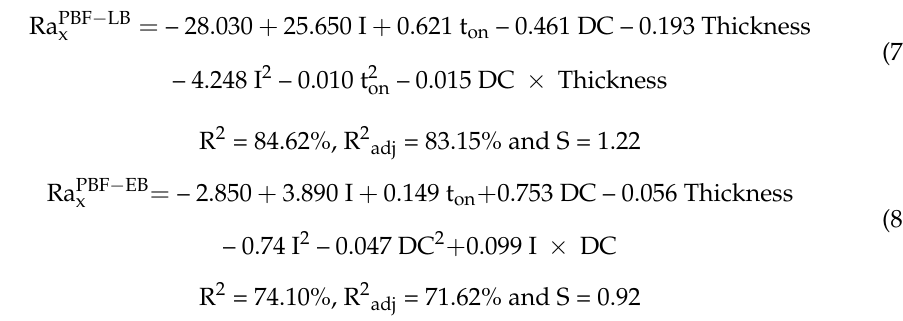
Figure 6. Residuals plots of the V c regressions models for ( a ) PBF-LB and ( b ) PBF-EB. The models inferred for Ra x reflect the results of ANOVAs. The two equations are characterised by different terms and coefficients (Equations (7) and (8), for PBF-LB and PBF-EB parts, respectively.